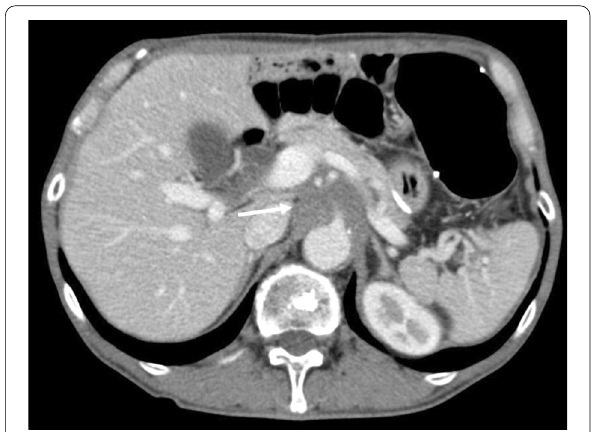
Fig. 4 After four courses of nivolumab, the size of the metastatic lymph node was 34 mm 31 mm (arrow) ×